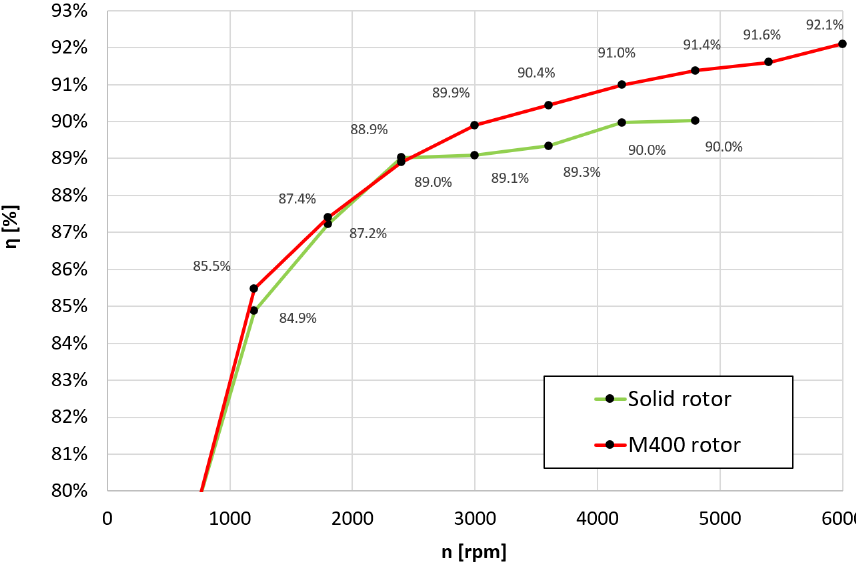
Figure 12. Comparison of the efficiency as a function of changes in rotational speed for the rated load current I N . current I N